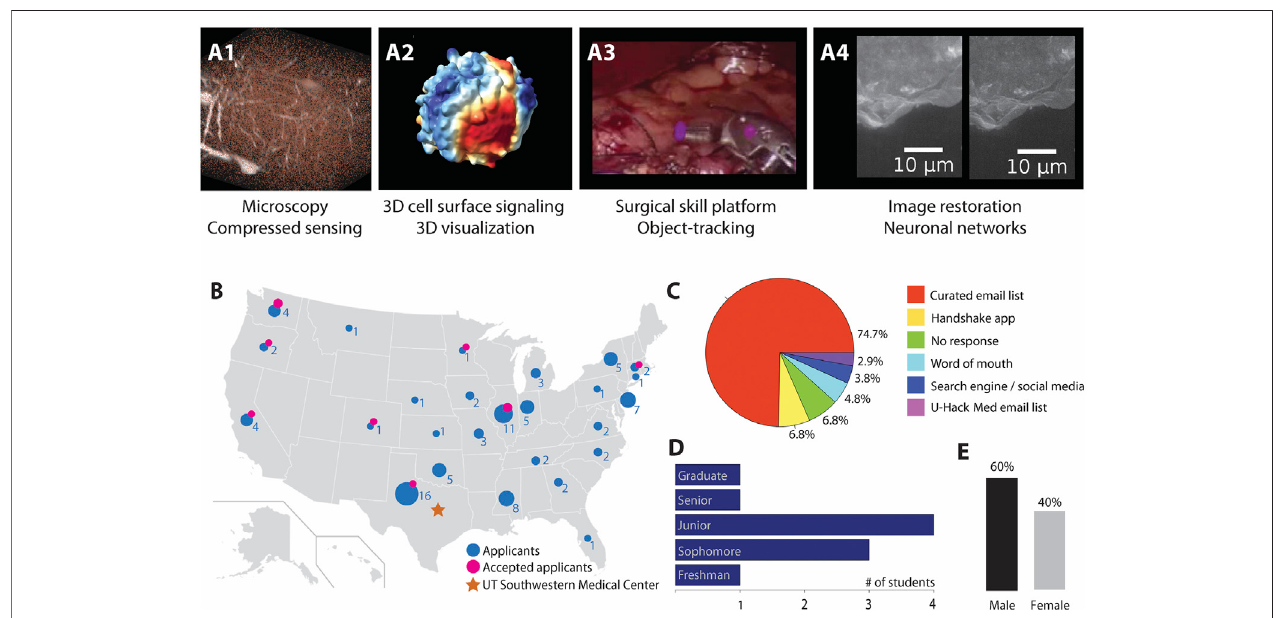
FIGURE 2 | Internship projects and student characteristics. (A1-A4) The internship projects spanned topics as diverse as microscopy, 3D visualization, surgical skill platform analysis and image restoration. (A1) A student applied compressed sensing algorithms (Rani, Dhok, and Deshmukh2018) to reconstruct an originalimage of mouse brain neurons (white) from sparsely sampled points (brown) in a 3D volume obtained by simulating a random-access microscope. (A2) A student analyzed molecularsignalson a3D cellsurface ofamelanoma cell(Driscollet al., 2019)and visualized theresultingdata. (A3) Astudent establishedafullpipeline toperform automated analysis to score the performance of different surgeons on a novel surgical skill platform (Battaglia et al., 2021). (A4) A student explored arti fi cial neuronal networks such as CARE (Weigert et al., 2018), to obtain higher resolution images (right) from raw data (left). (B) Applications (blue, circle size scaled for number of applications) for the U-Hack Gap Year were received from all over the US. Consequently, participating students (pink, circle size scaled for number of interns) were working remotely from all over the US, while the mentors were working at UT Southwestern in Dallas (orange). (C) Source of information that made participant aware